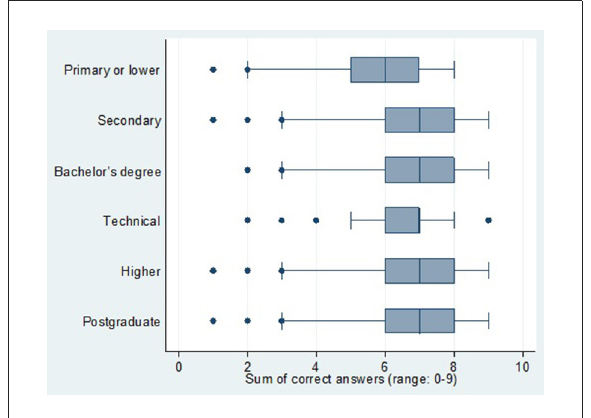
as reference for comparison, Chile, Paraguay, Mexico, Bolivia, Panama, Ecuador, Costa Rica and Colombia had a better level of knowledge (all p -values were < 0.001); however, only El Salvador had a lower level p < 0.001) (Table